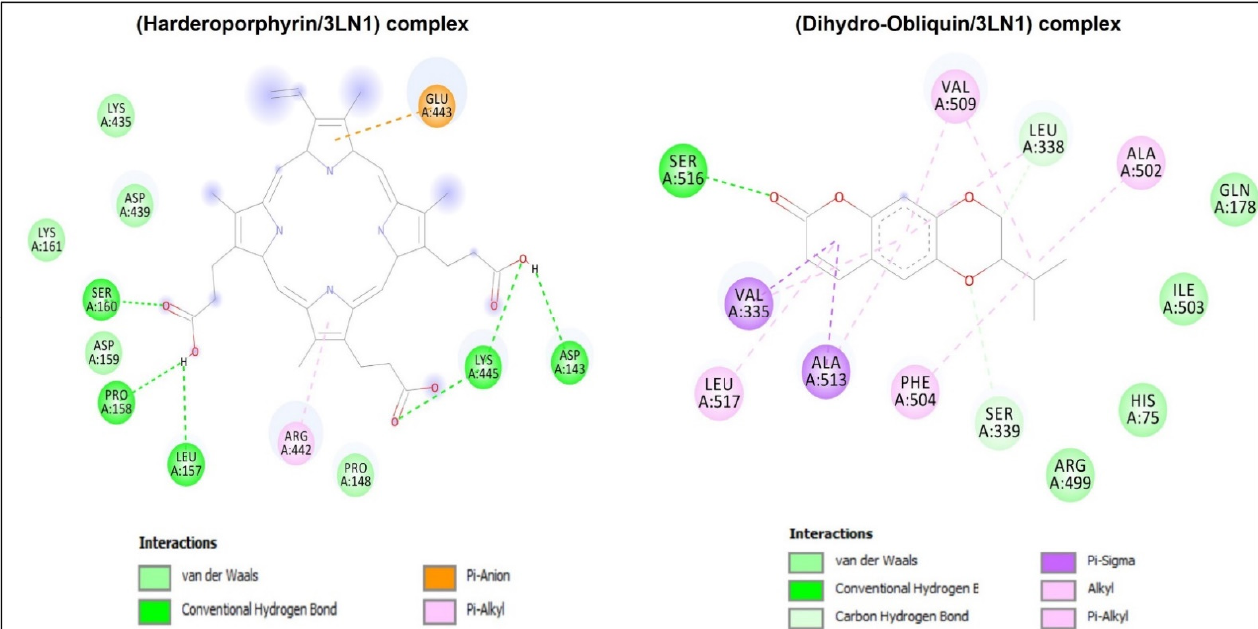
Figure 3. Three-dimensional (3D) residual interactions network of the best selective compounds with the active site of human peroxiredoxin 5 protein (PDB ID: 1HD2), C. albicans Sap1 (PDB ID: 2QZW), and S. aureus IIA topoisomerase (PDB ID: 2XCT).